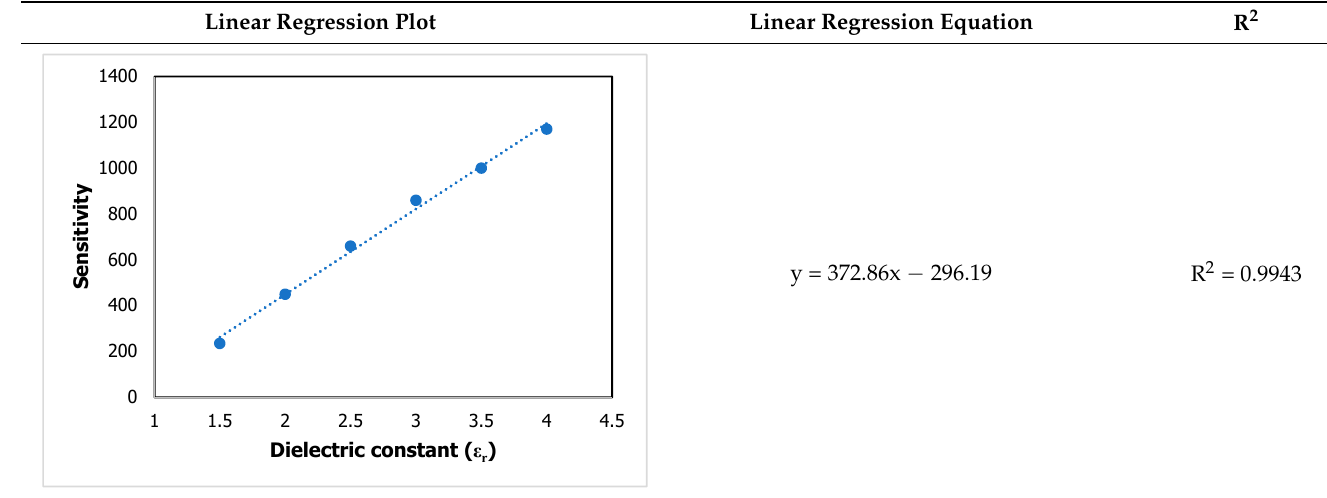
Table 5. Linear regression graph and regression equation at 3.56 and 4.14 GHz. Linear Regression Plot Linear Regression Equation R 2